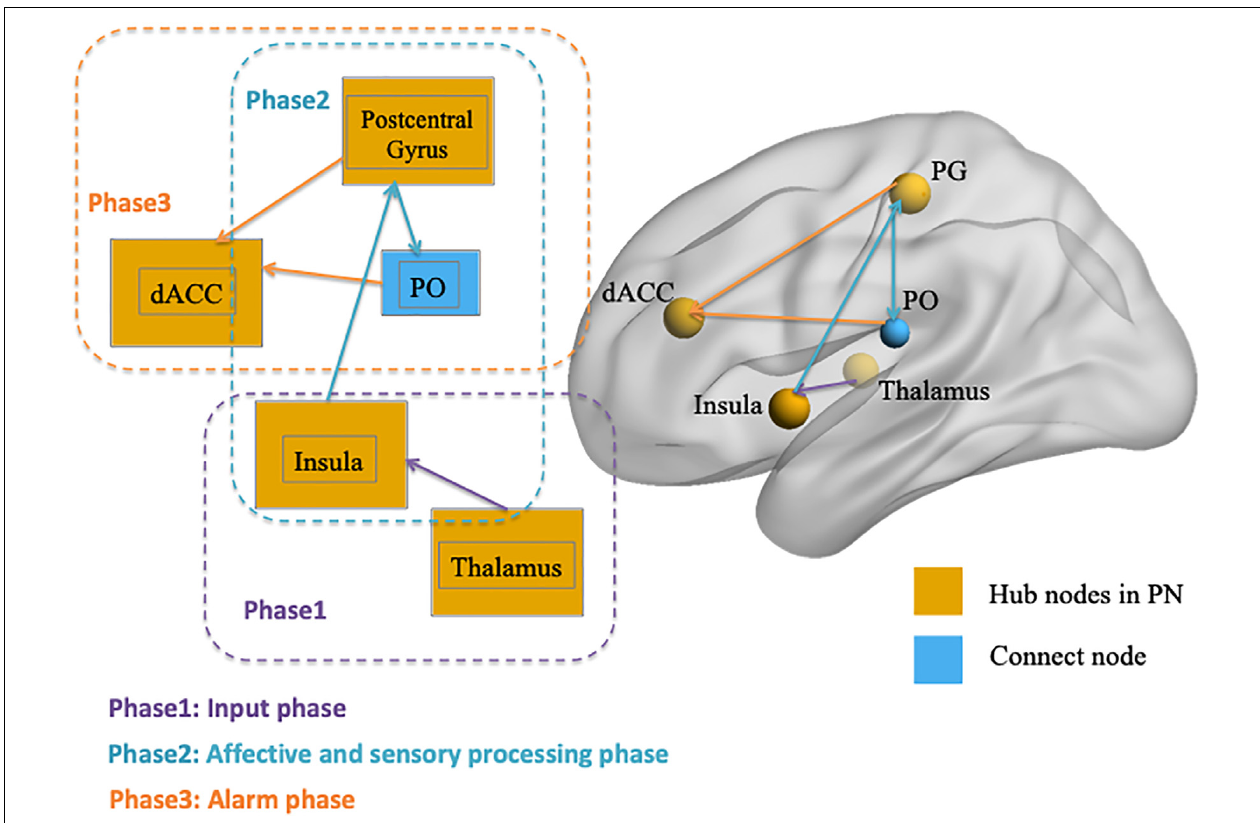
FIGURE 4 | Illustration of the three-phase ascending pathway in the punishment network (PN). Phase 1 is the “input phase” and refers to the connectivity from the thalamus to the insula; Phase 2 is the “affective and sensory processing phase” and refers to the connection between the insula, postcentral gyrus (PG), and parietal operculum (PO); and Phase 3 is the “alarm phase” and refers to the connectivity within PG, PO, and dACC. The visualization was provided by BrainNet Viewer (http://www.nitrc.org/projects/bnv/).